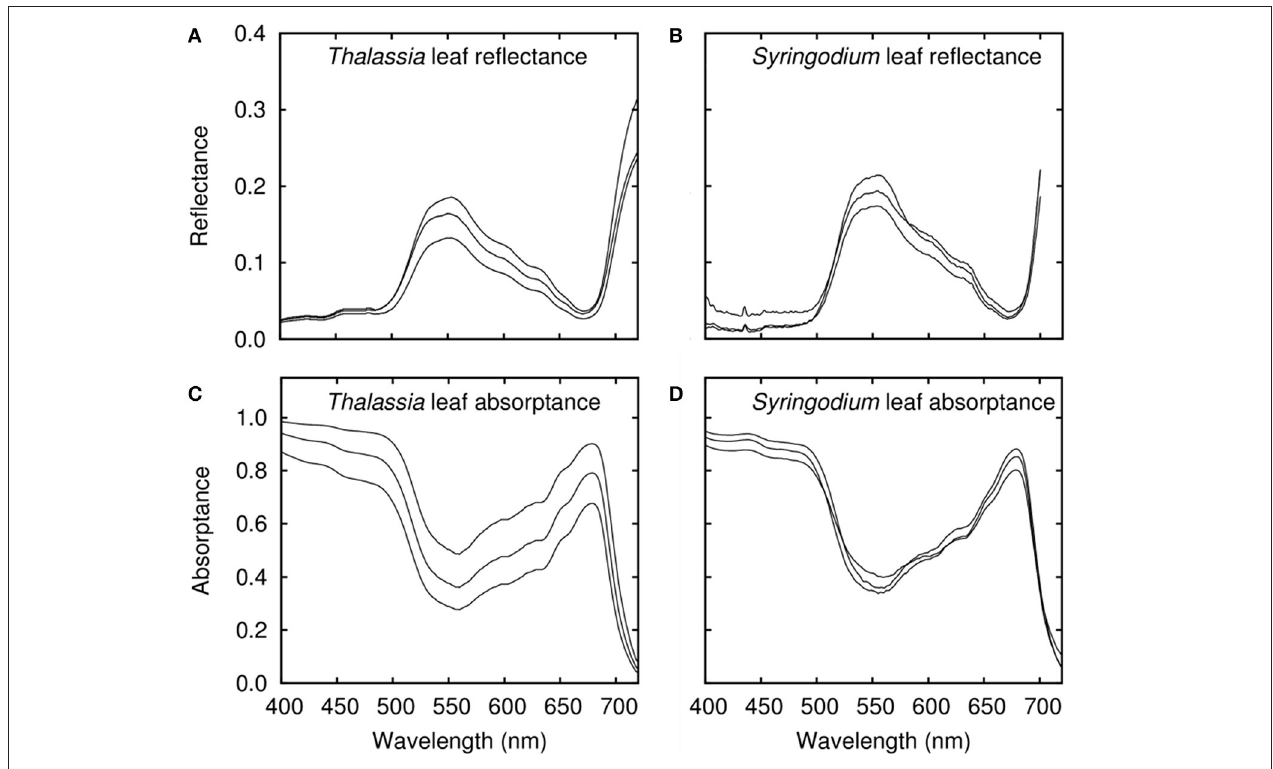
FIGURE 2 | Leaf level reflectances and absorptances as used in the modeling for (A,C) Thalassia and (B,D) Syringodium . Each plot shows three lines, corresponding to the high, medium, and low reflectance variants (high reflectance being paired with low absorptance